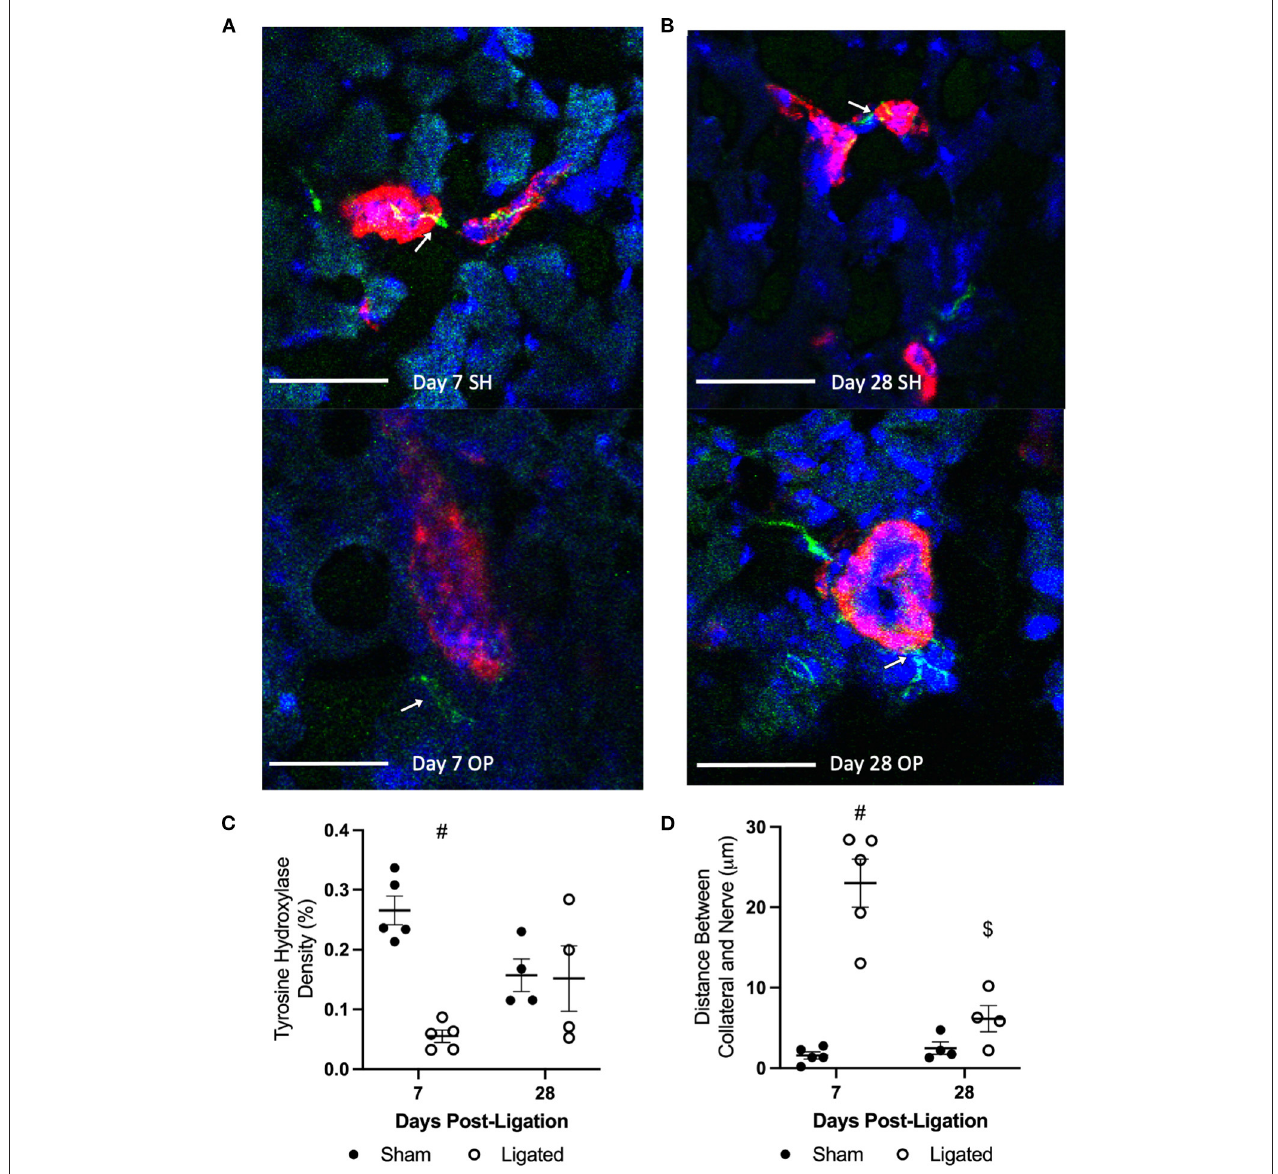
FIGURE 7 | Sympathetic neurons occupy less area and are further from the collateral at day 7. Transverse cross sections of collateral vessel midzone was observed by confocal microscopy at 7 days (A) or 28 days (B) post-femoral artery ligation in the left mouse hindlimb, after tissue sections of gracilis muscles from ligated (OP, bottom) and sham operated (SH, top) hindlimbs were incubated with anti- α -smooth muscle actin (collateral vessel, red), anti-tyrosine hydroxylase (sympathetic neuron, green, indicated by arrows), and BBI (nuclei, blue); scale bar indicates 50 µ m. Sympathetic neurons occupy less area in the peri-collateral region of enlarged collateral at 7 days ( C , n = 5, 3 male and 2 female) but not 28 days ( D , n = 4, 2 male and 2 female). The sympathetic neurons were also further away from the enlarged collateral at 7 days but not 28 day ( # p < 0.05 vs. sham, $ p < 0.05 vs. day